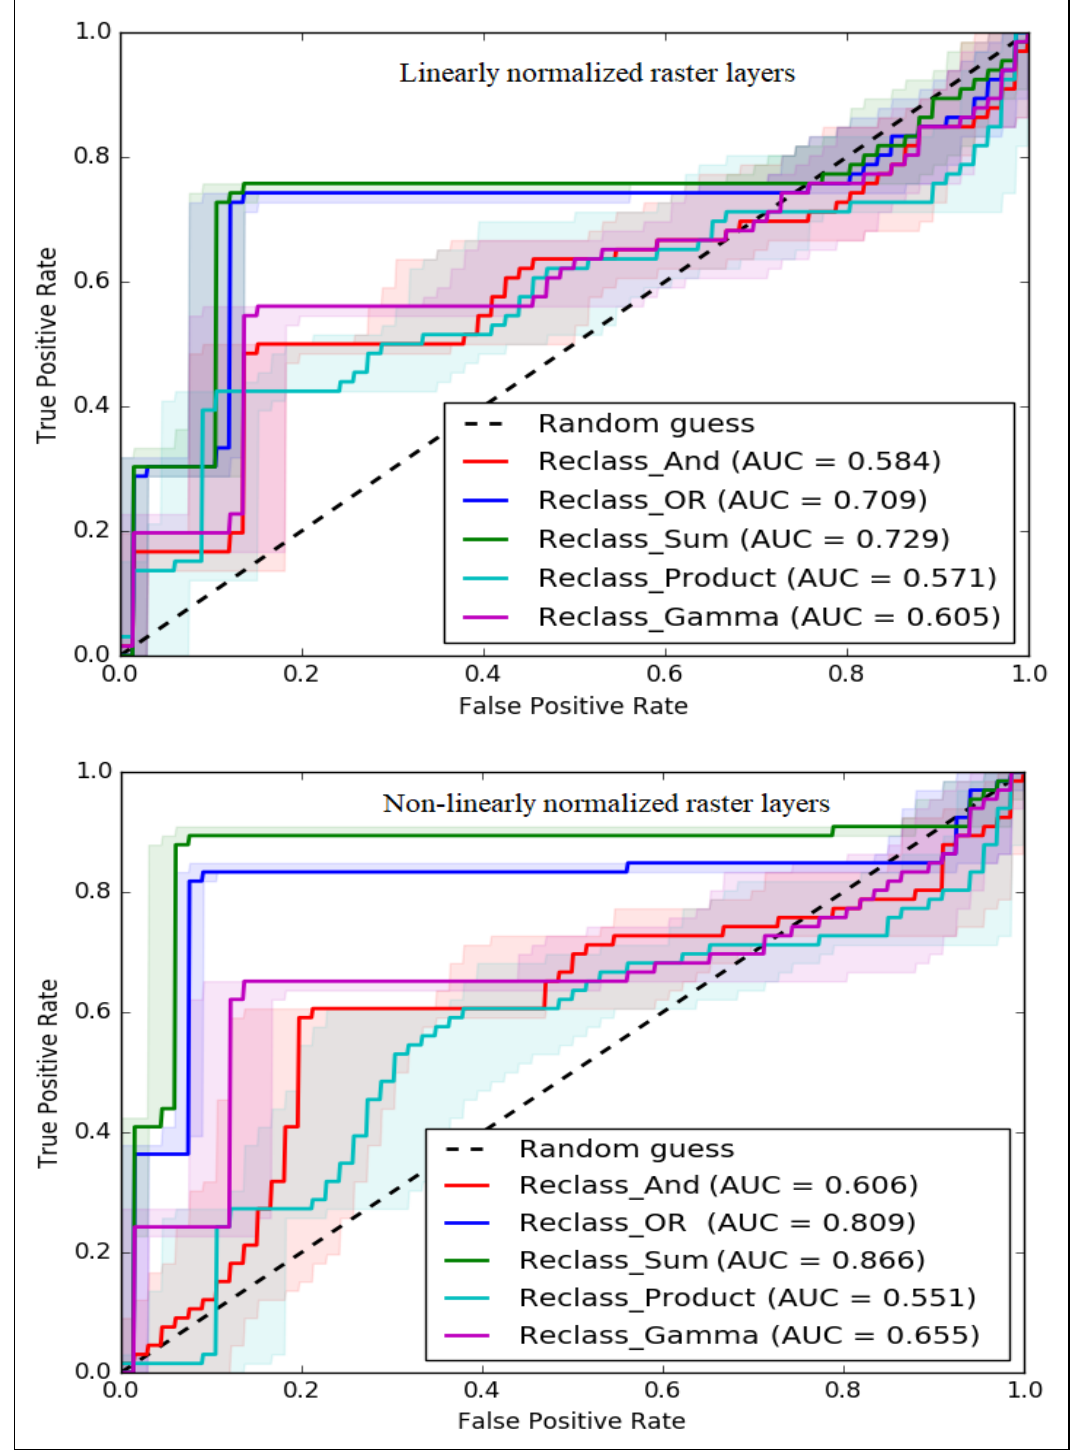
Figure 5. ROC curves and AUC values for the developed soil pollution maps .